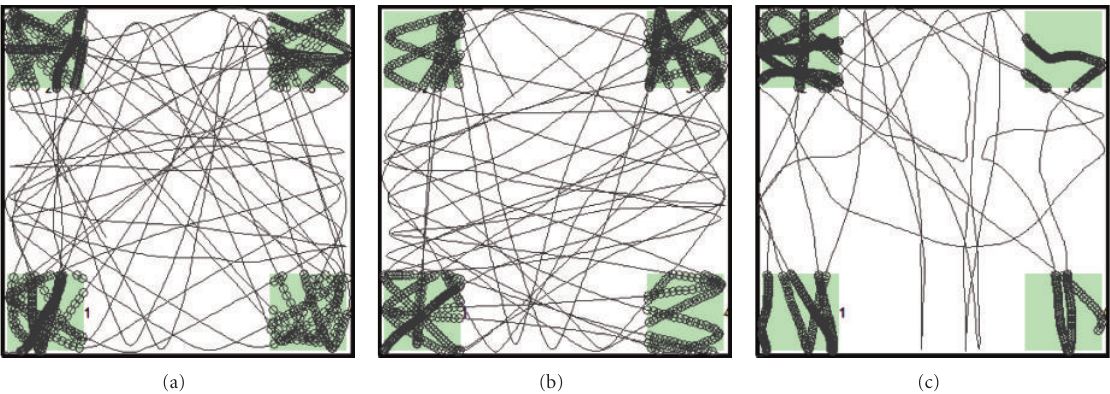
Figure 6: Three trajectory datasets from a nonoverlapping 4-camera network. Shaded squares indicate the field of view of each camera, circles denotes the observed object locations, and lines show the portions of the trajectories unobserved by the